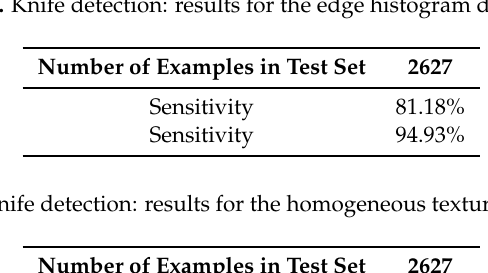
Table 3. Knife detection: results for the edge histogram descriptor.